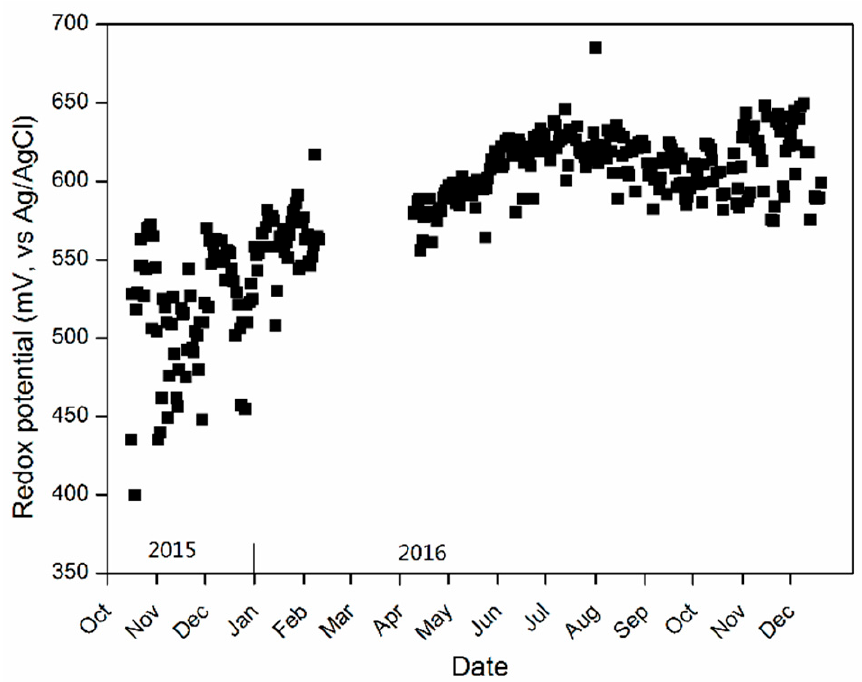
Figure 5. Redox potential of the leachate from cell P3C6. During heap bioleaching, leachate in February, May, September, and October were collected, respectively. Solutions were added with 2 g/L Fe 2+ and cultured in an oscillator (35 ◦ C) in laboratory to test the microbial iron oxidizing activity. The iron oxidizing activity was higher in May and September so that the Fe 2+ were oxidized in about 3.5 and 2.5 days, respectively (Figure 6). While in February, the microbes continued to grow after inoculated to heaps (Fe 2+ were oxidized in about 6 days); and in December (Fe 2+ were oxidized in about 5.5 days); the low pH and accumulated ions (total dissolved solids at 80.2 g/L at December, 2016) in solution may start inhibiting the microbial